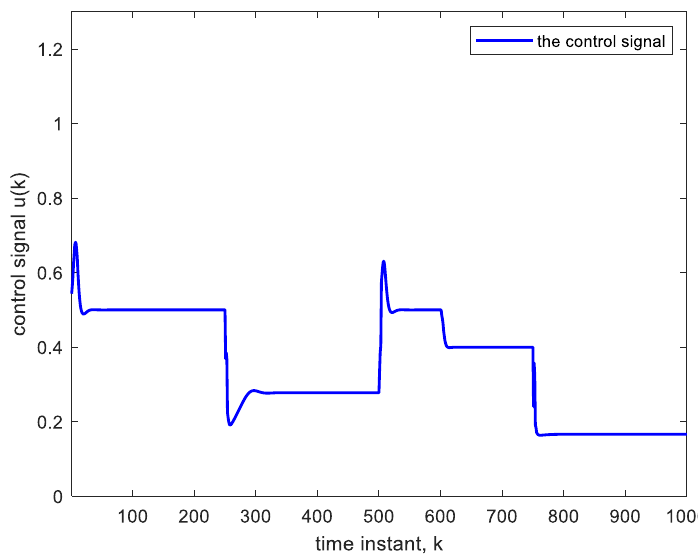
Figure 9. Control signal corresponding to Figure 8.